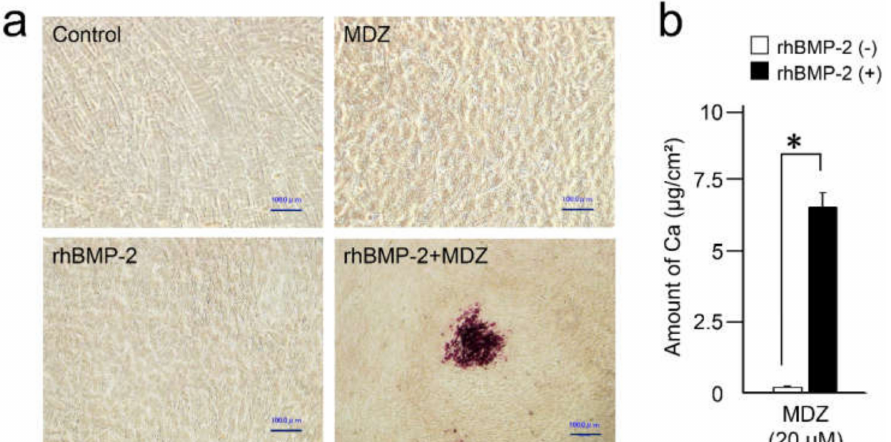
Figure5. Combinede ff ectofMDZandBMP-2onthemineralizednoduleformationintheC2C12cells. ( a ) Alizarin red S staining for nodule precipitates on day 10. C2C12 cells cultured in mineralization-inducing culture media in the absence (Control) or presence of MDZ alone (MDZ), rhBMP-2 alone (rhBMP-2), and the combination of rhBMP-2 and MDZ (rhBMP-2 + MDZ). The rhBMP-2 + MDZ exhibited nodule formation (scale bar = 100 µ m). ( b ) Calcium contents in C2C12 cells were determined on day 10 after the mineralization induction. The amount of calcium increased in C2C12 cells cultured in mineralization-inducing culture media with 10 or 20 µ M of MDZ in the presence of rhBMP-2. Values are the means ± SEM of 12 culture wells. Asterisk (*) indicates a significant di ff erence ( p < 0.01, Mann-Whitney U test) between the cells incubated with and without